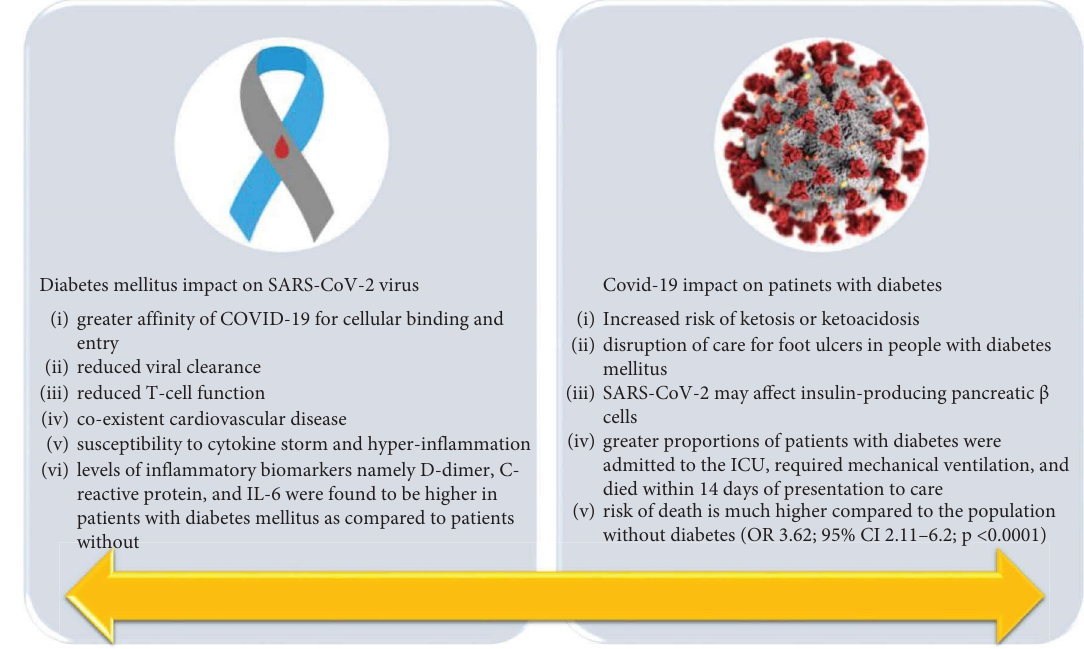
Figure 2: Most important characteristics/changes induced by COVID-19 in diabetes